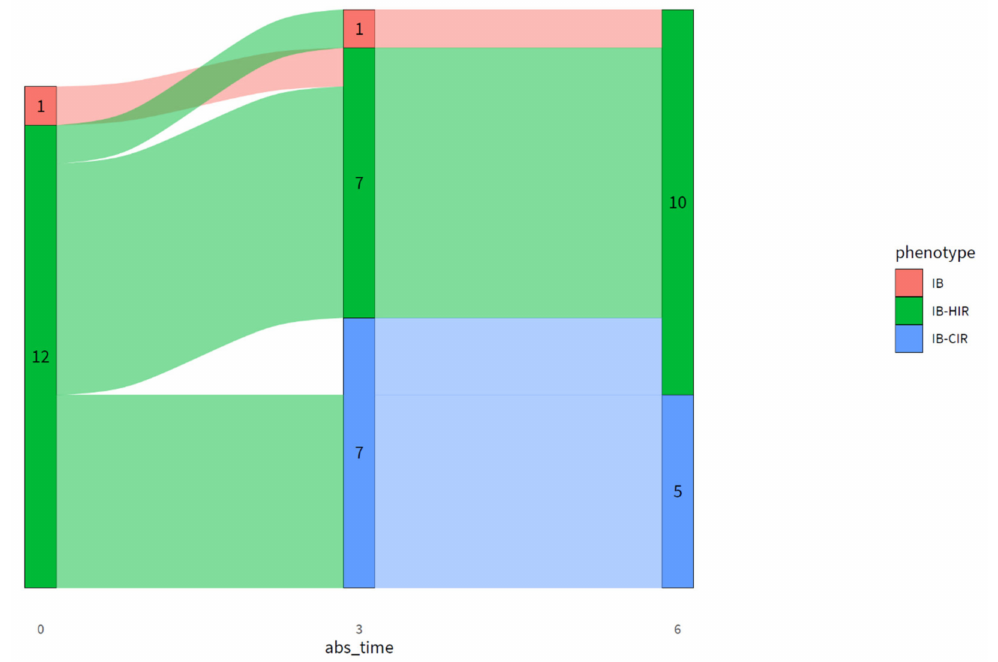
Figure 1. Flow diagram showing the diabetic subtypes at baseline, three months, and six months; subtype from two participants could not be calculated at baseline due to missing data. IB = impaired beta cell function; HIR = hepatic insulin resistance; CIR = combined (liver and muscle) insulin resistance. Abs_time: time of intervention (months). Numbers within the figure indicate the number of participants with that particular subtype at each time of